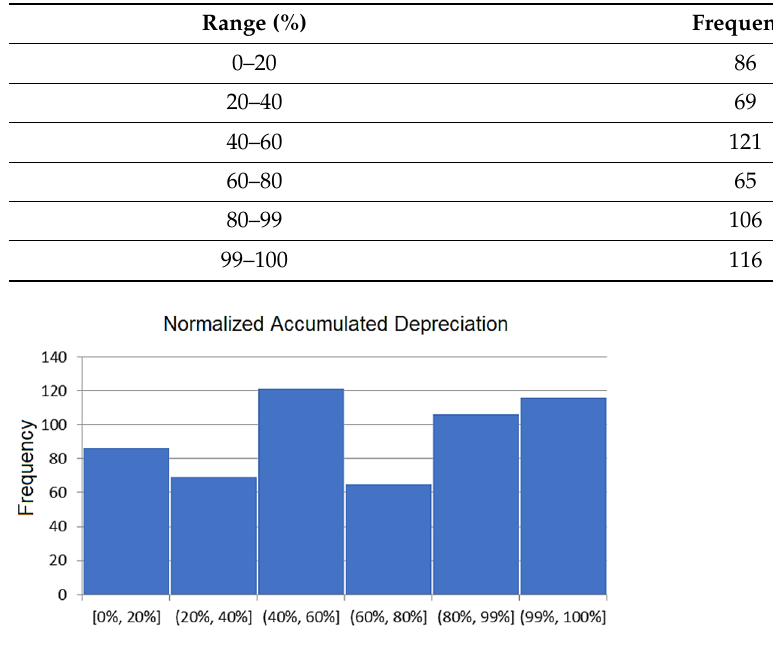
Figure 9. Dispersion of scores relating to the accumulated depreciation and benefit criteria weighted against global scores [authors].